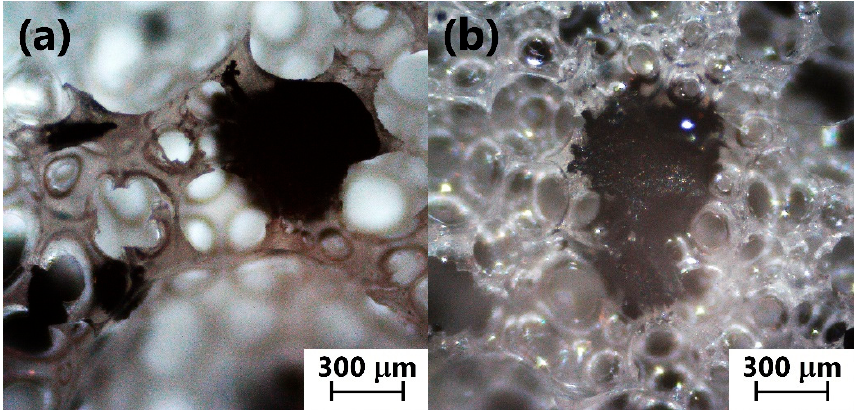
Figure 4. Growth of cells on the GTR surface for ( a ) PU/GTR and ( b ) PU/GTR 40WO samples.